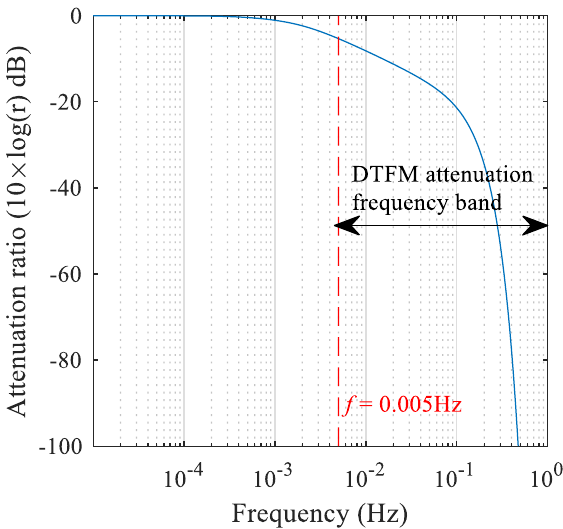
Figure 4. Modeling results of the temperature fluctuation ratio of the dynamic thermal filtering method (DTFM) attenuator.